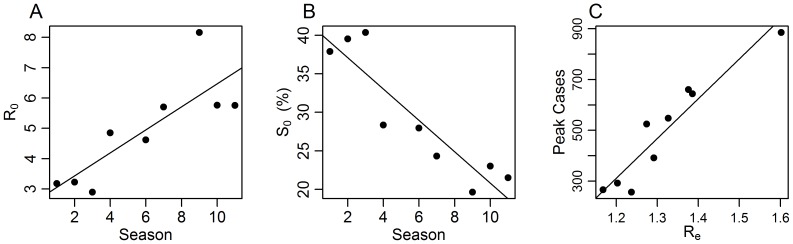
Correlations of several epidemiological parameters in the ILI dataset.The relationship between season (time) and R
0 (A), season and S
0 (B), R
e and maximum number of ILI cases at the peak of the outbreak (C). In these analyses we used only A seasons (n = 9).